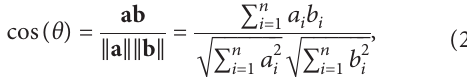
Algorithm 1, a distance function d is redefined first.